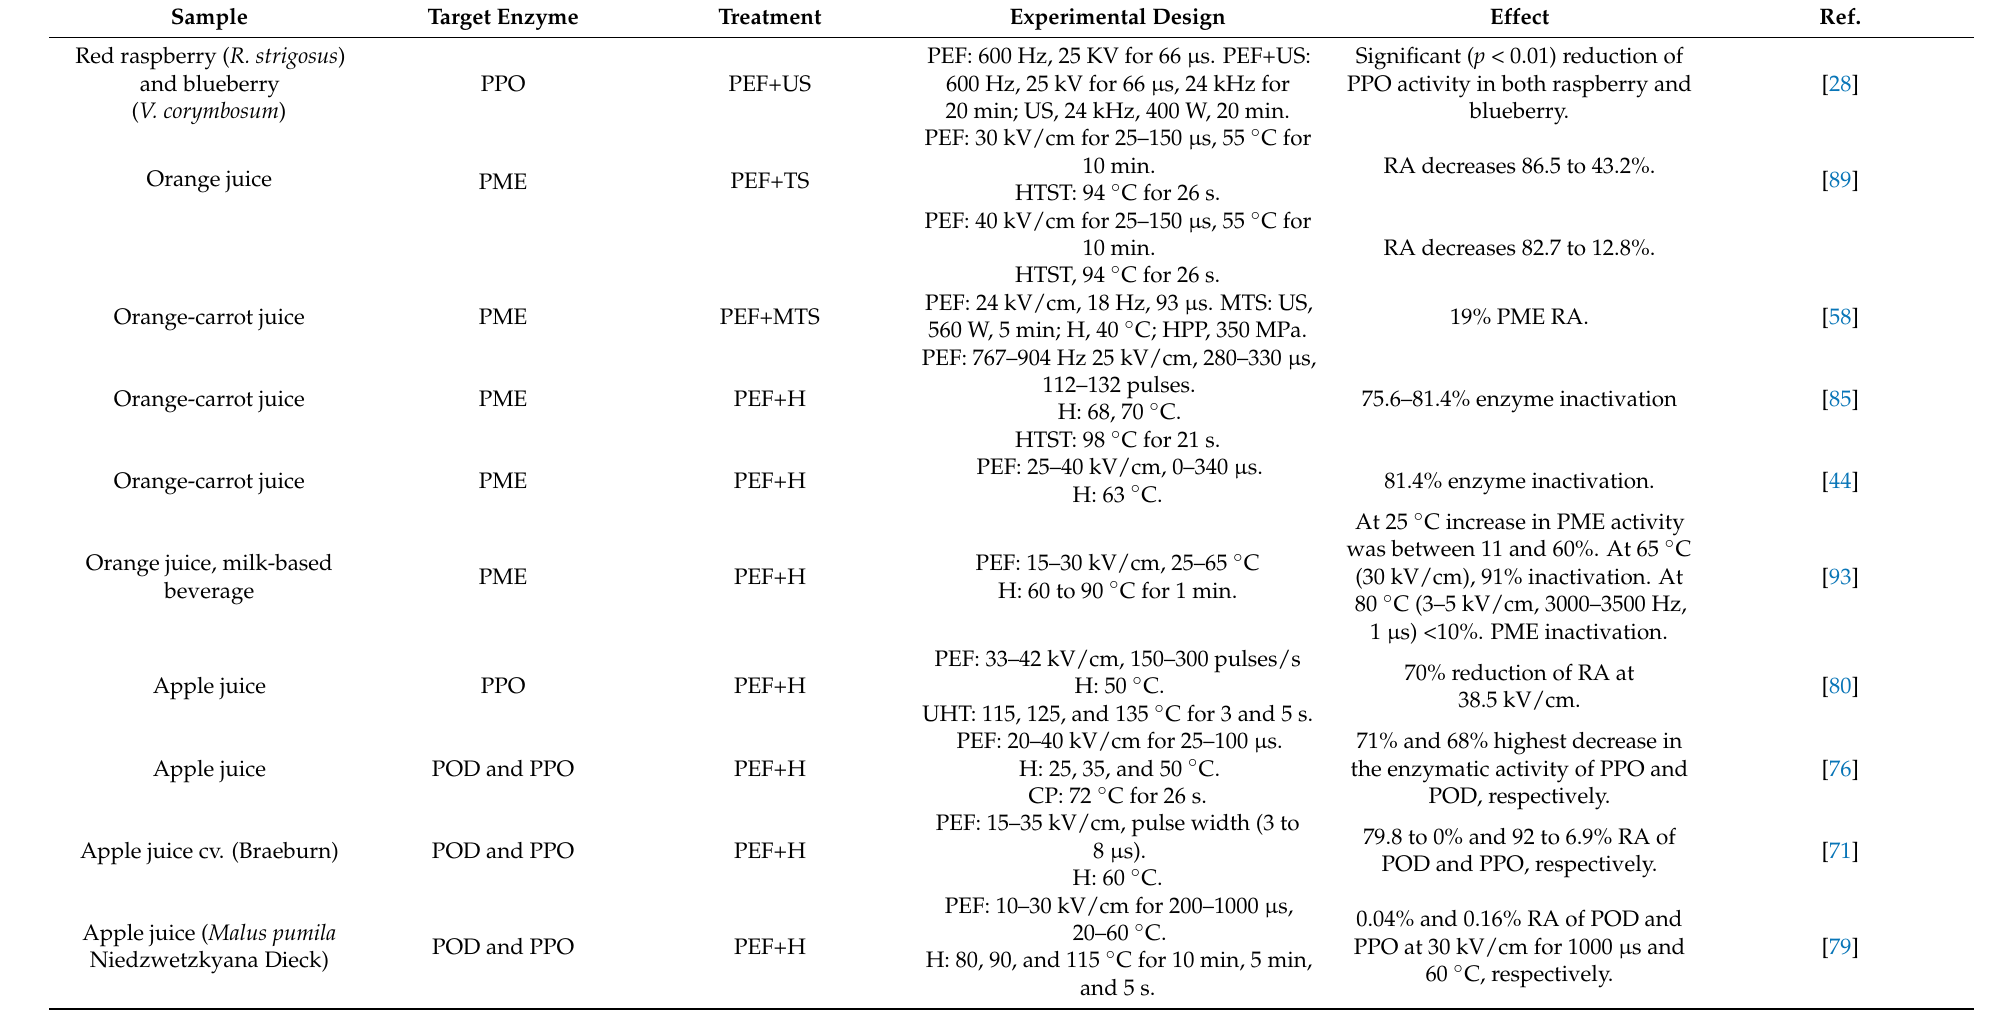
Table 2. Combined PEF Treatments with Other